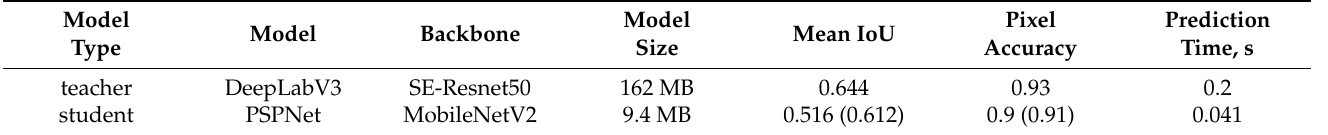
Table 2. Comparison results of teacher and student